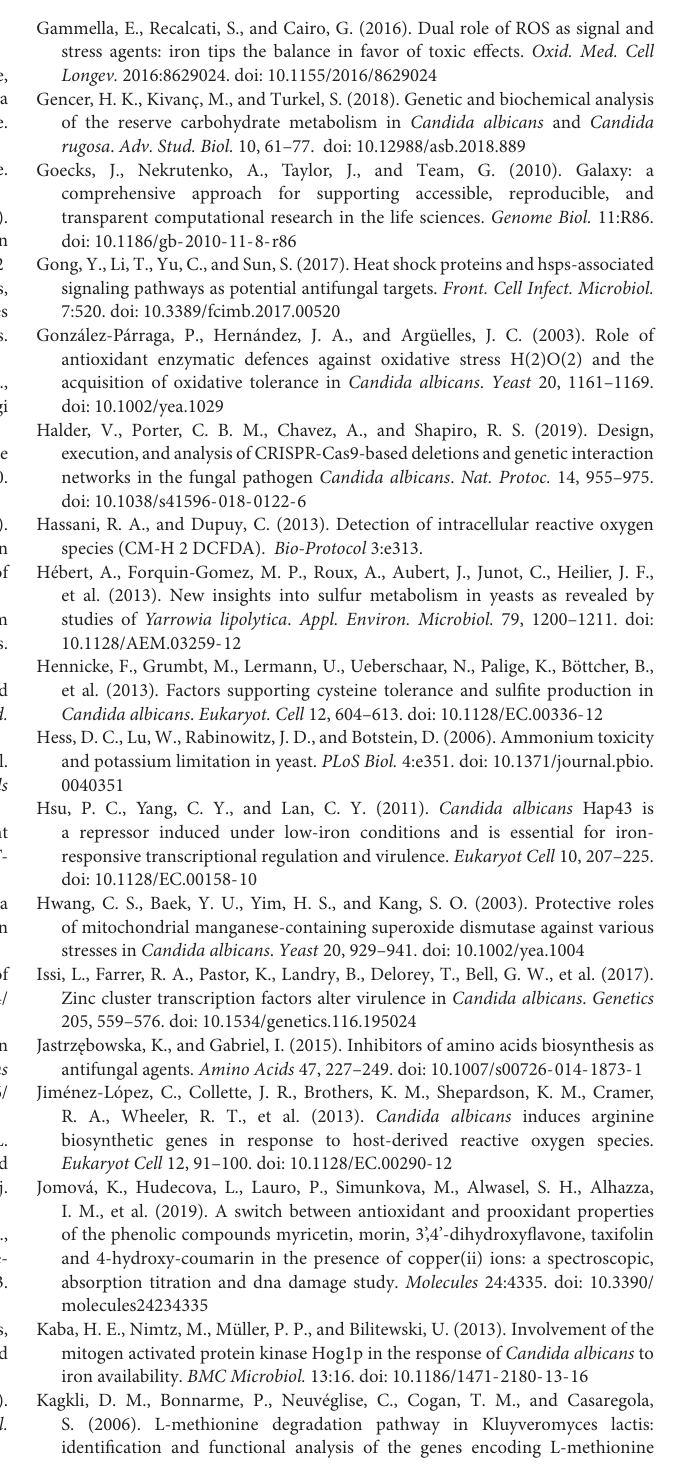
Supplementary Table 3 | Gene expression analysis of SH9051. Supplementary Table 4 | List of gene drive construct and primers. Supplementary File 1 | RNA samples quantity and